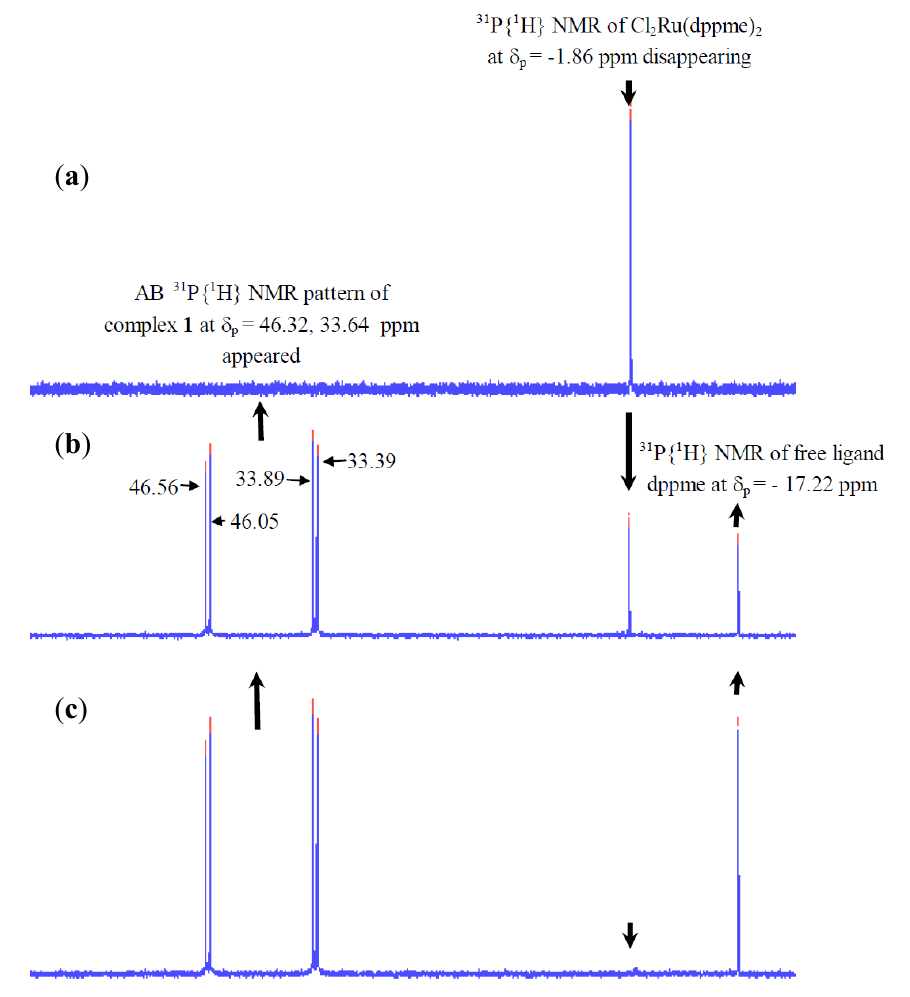
(dppme) ] at  = − 1.86 ppm 2 2 p